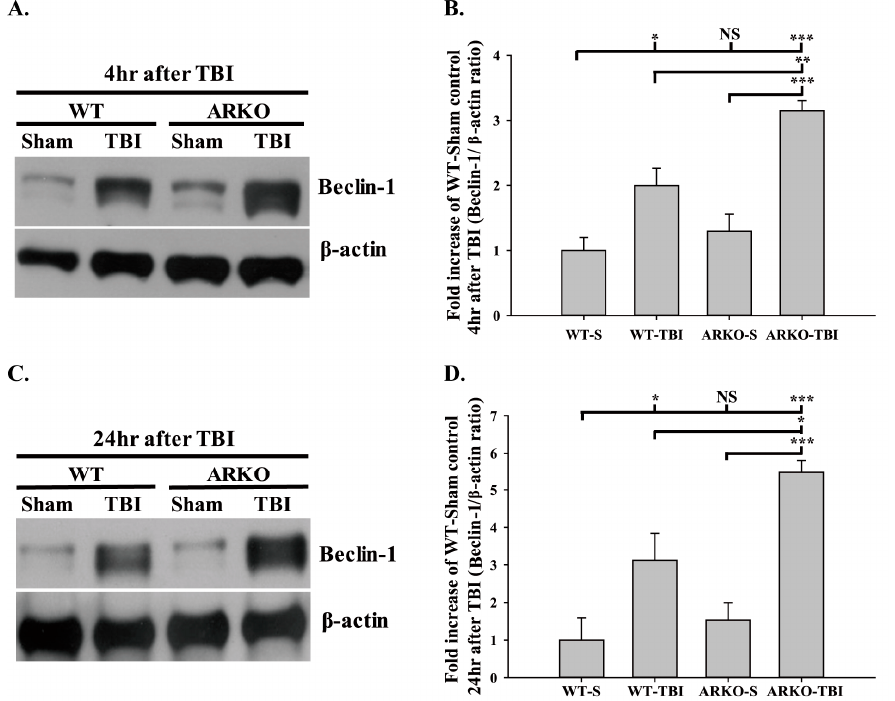
Figure 4. Androgen receptor knockout increases the TBI-induced Beclin-1 expression after brain injury. ( A ) TBI increases Beclin-1 expression. However, knockout of androgen receptor further increases Beclin-1 expression 4 h after injury. ( B ) Quantitative level of Beclin-1 expression at 4 h following TBI. ( C ) Beclin-1 expression shows a significant increase in ARKO mice, compared with WT mice in 24 h following TBI. ( D ) Quantitative level of Beclin-1 expression at 24 h following TBI. All data are presented as the mean ± standard error. NS, no significant difference; * p < 0.05, ** p < 0.01, and *** p < 0.001; n = 3 in each group.